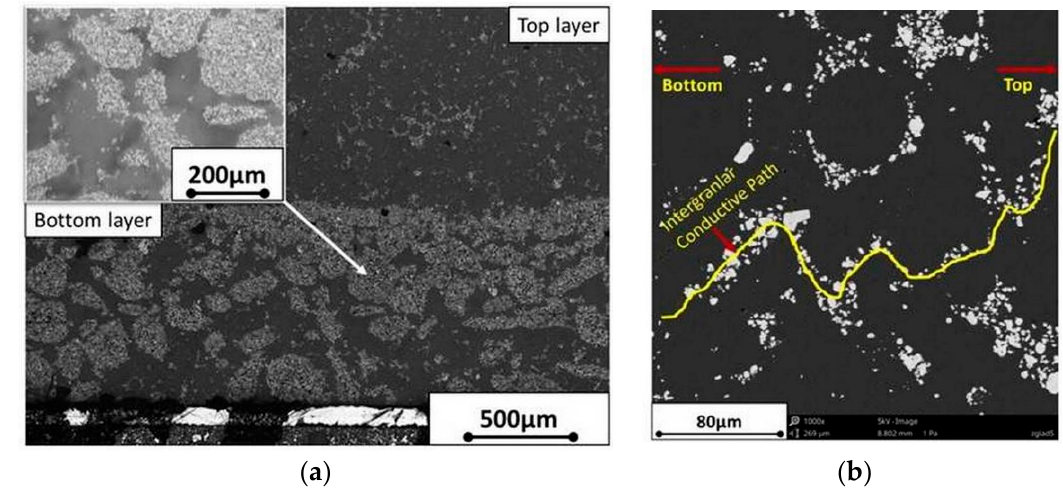
Figure 5. Cross-sections of the manufactured composite beam: ( a ) cross-section of both top (polymer) and bottom (piezoelectric) layer observed by optical microscope; ( b ) SEM cross-section observations of only the top (polymer) layer with PZT fine particles distributed in the matrix building conductive